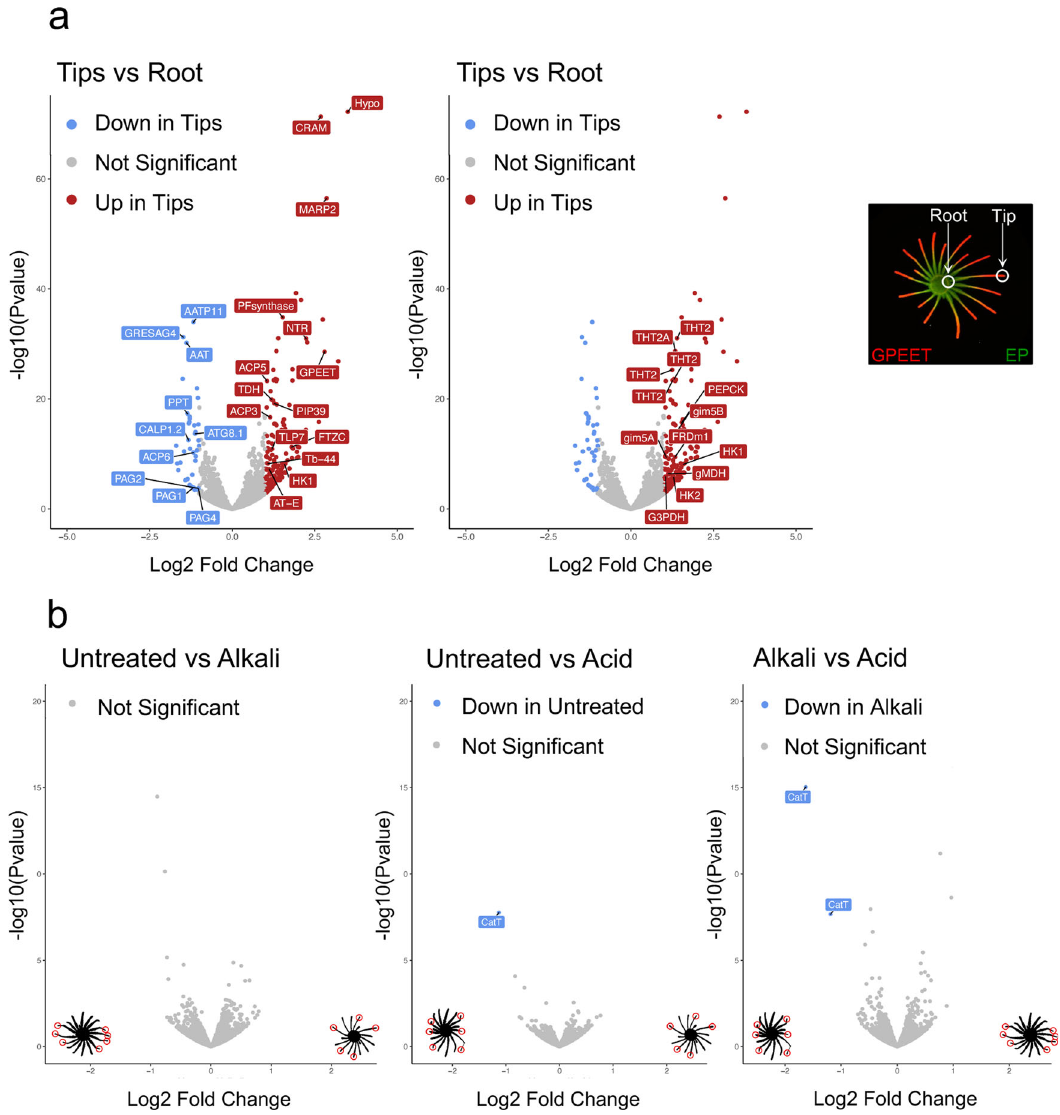
Fig. 4 Volcano plots comparing transcriptomes of cells from different regions of a community or following exposure to acid or alkali. DTM plates were inoculated with cells from liquid cultures of early procyclic forms (EATRO1125) in DTM medium. a Comparison of the roots and tips of projections. For clarity the same volcano plot is displayed twice with different transcripts annotated. Left: early procyclic form markers, such as GPEET, cal fl agin, hexokinase 1 and prostaglandin F synthetase are upregulated in tips. Adenylate cyclases such as ACP3, ACP5, and ACP6 are differentially expressed between tip and root. Right: glycolytic enzymes and genes involved in glucose metabolism are upregulated in tips. Far-right panel: community lift of a representative SoMo plate 7 days after inoculation stained for EP (green) and GPEET (red). Tips were isolated when projections were ≥ 2.5 cm in length. RNA-seq was performed in duplicate. b Pairwise comparisons of untreated communities and communities exposed to acid or alkali. Tips were isolated from projections showing a clear response to the treatment (indicated with red circles). RNA-seq was performed in triplicate. The illustrations in the left and right bottom corners of the volcano plots show SoMo communities (in black) and the samples that were collected (red circles). Analysis was done using DESeq2 bioconductor package to identify the differentially expressed genes. The package integrates Wald statistics to identify signi fi cantly regulated genes and adjustments were made for multiple comparisons with FDR/Benjamini-Hochberg 69 . Source data are provided as a Source Data fi